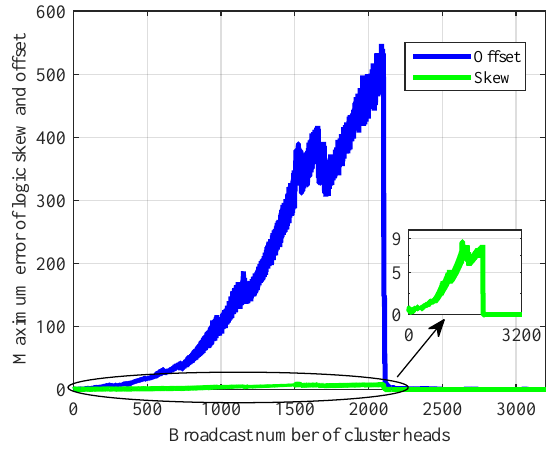
Figure 9. Comparison the property of Revised-CMTS and CMTS in inter-cluster time